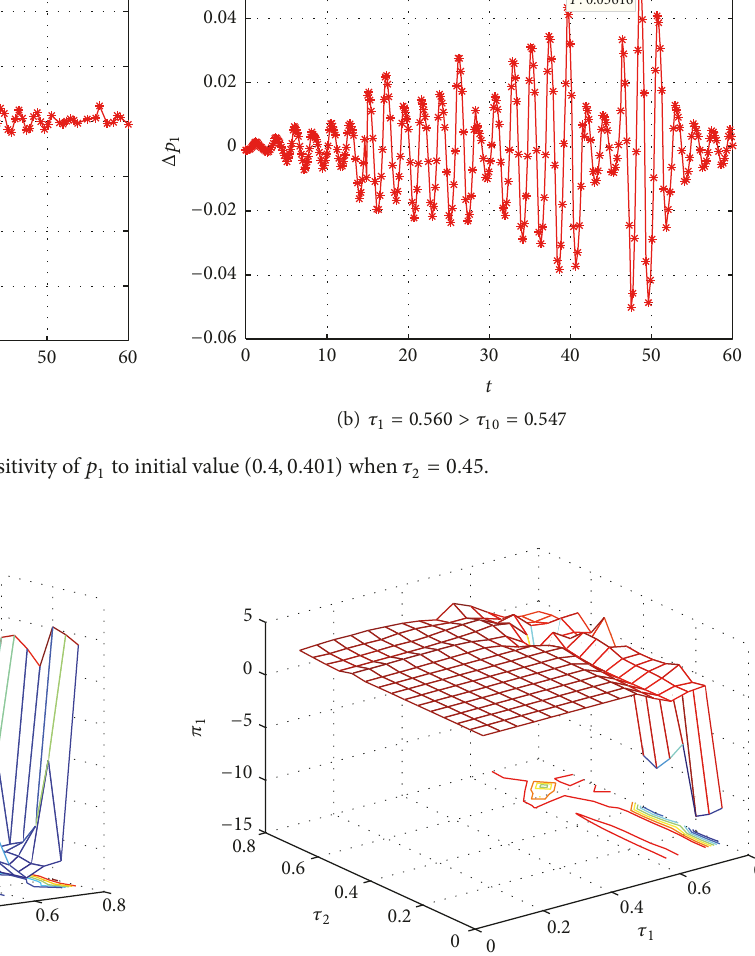
Figure 5: The influence of 𝜏 1 and 𝜏 2 on price. Figure 6: The influence of